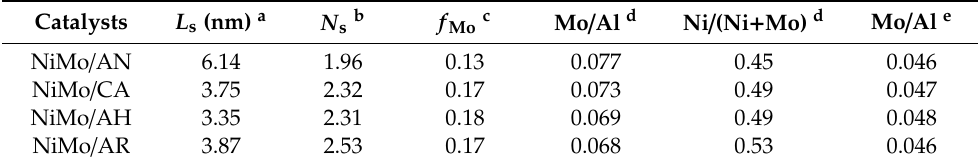
Figure 5. ( a ) Length and ( b ) stacking distribution for MoS 2 slabs over sulfided NiMo/Al 2 O 3 catalysts. Table 4. Typical properties of the NiMoS Table 4. Typical properties of the NiMoS catalysts.